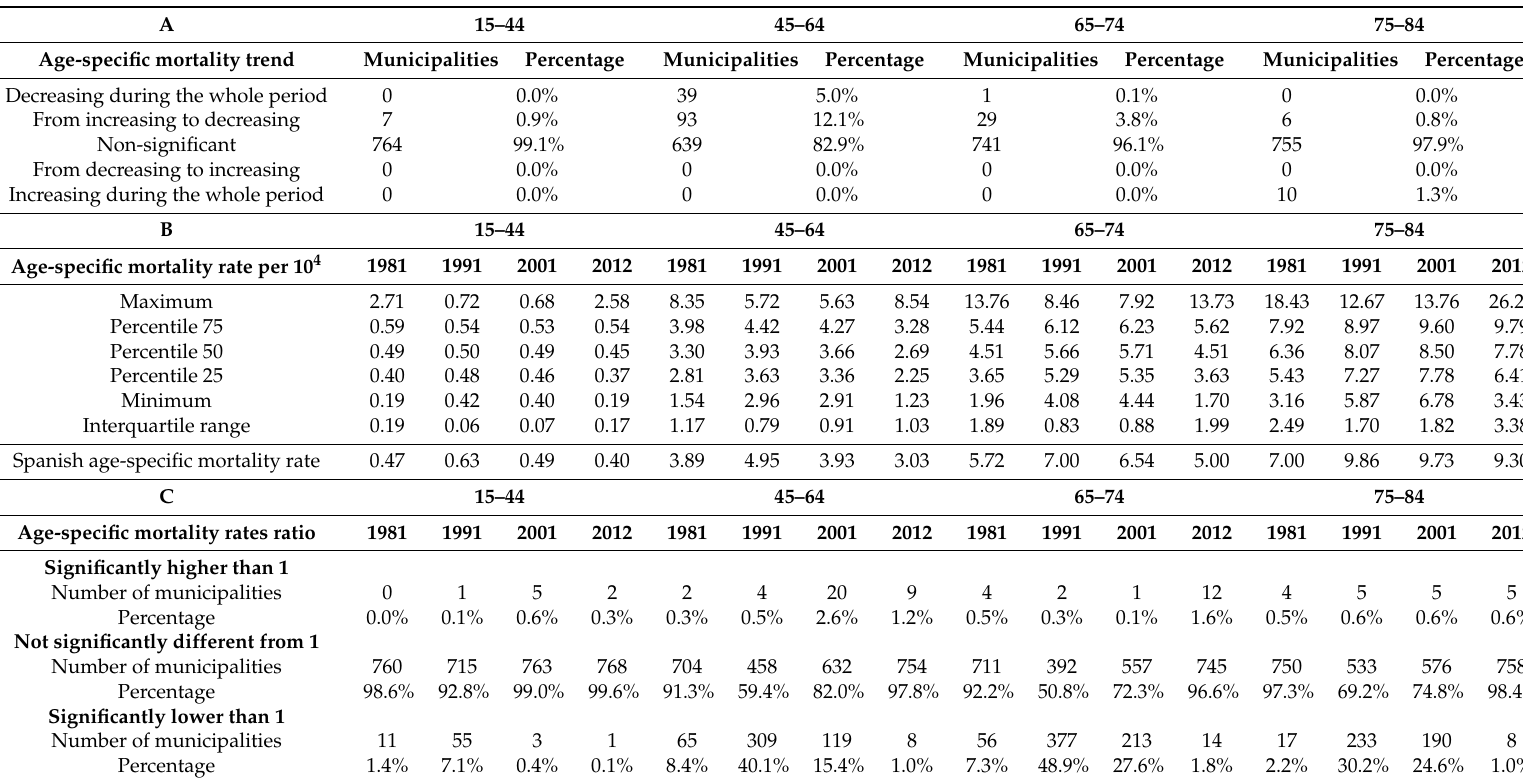
Table 3. Age-specific mortality trend, age-specific mortality rate and age-specific mortality rates ratio from female breast cancer in the municipalities of Andalusia,